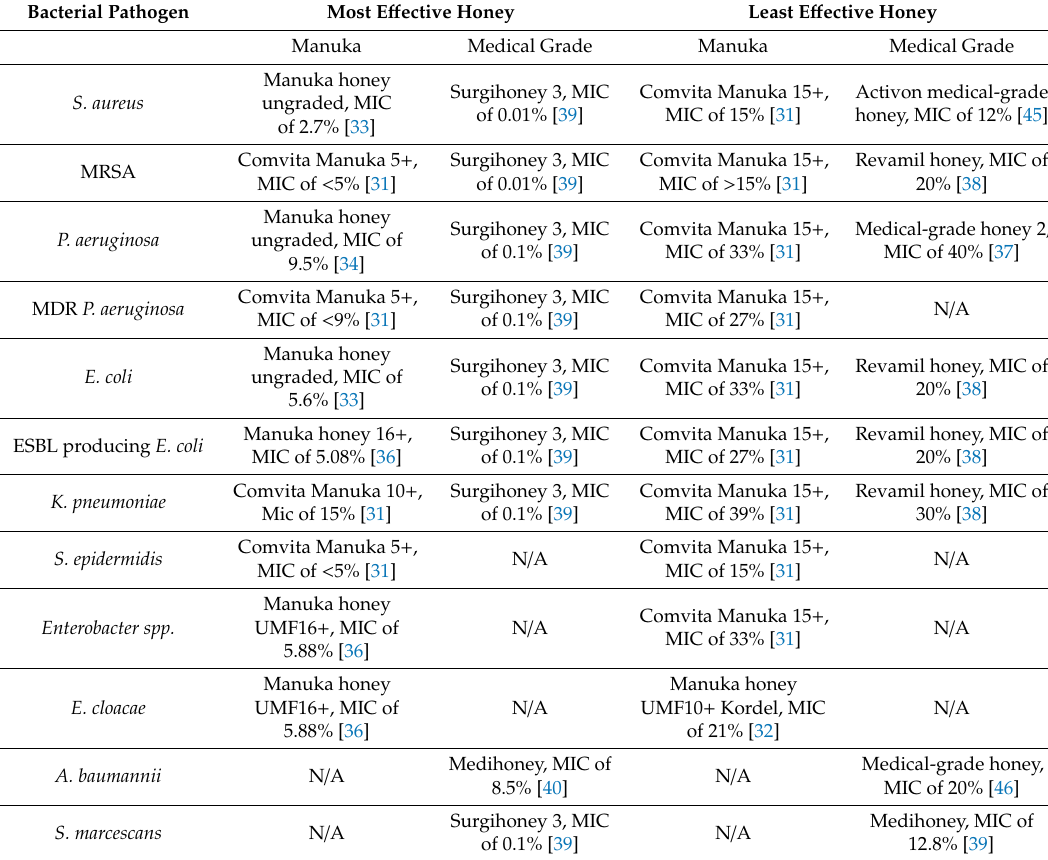
Table 2. Overall bacterial pathogen susceptibility: identifying the most e ff ective and least e ff ective Manuka and medical-grade honeys.